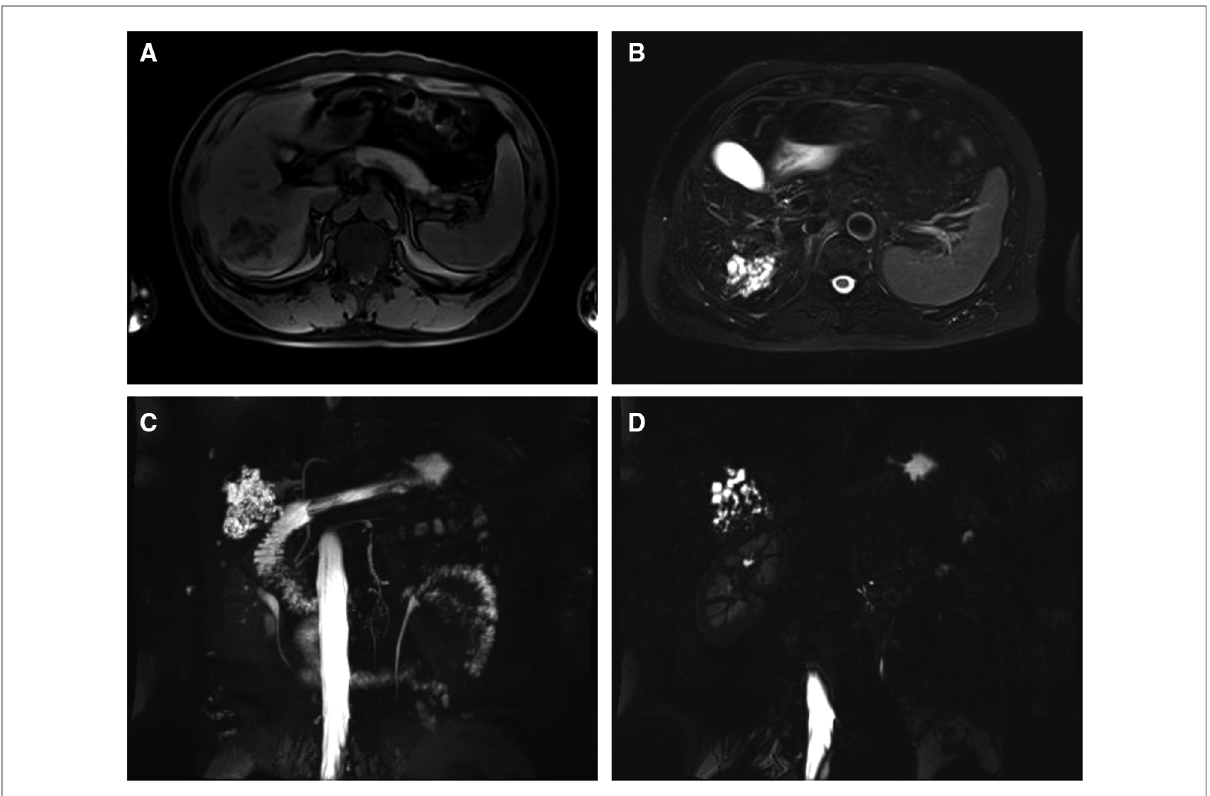
FIGURE 2 MRI fi ndings of a lesion that is an irregular tubular ( A ) low-density area on T1 and ( B ) high-intensity area on T2. ( C ) and ( D ) MRCP fi ndings of the mass that does not communicate with the bile duct. The intrahepatic and extrahepatic bile ducts are not